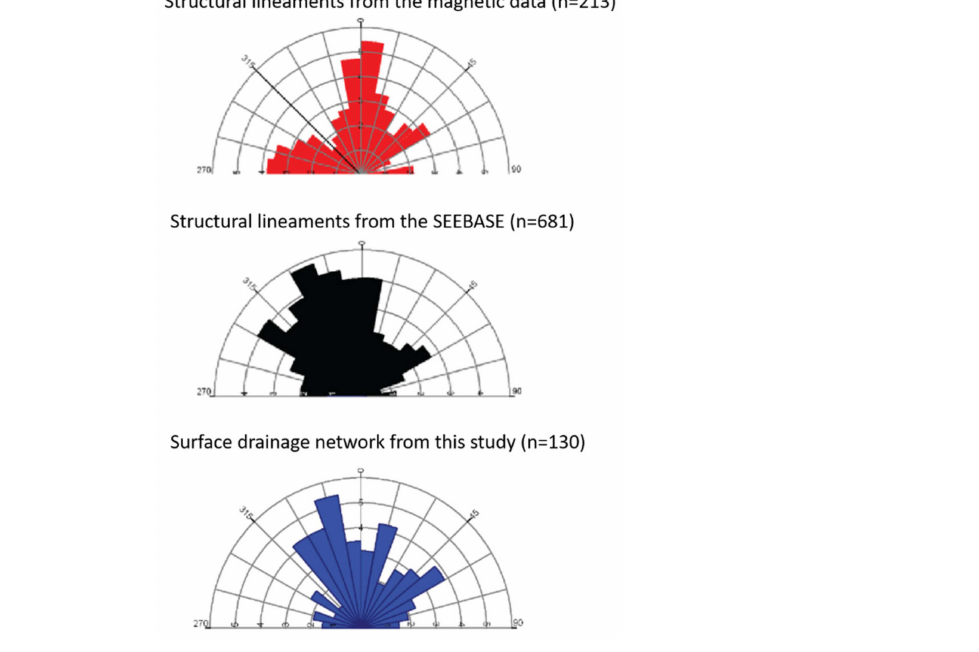
Figure 9. Published structural lineament from the magnetic data and SEEBASE ([39,60] analysis and this study unfiltered surface drainage network (see Figure